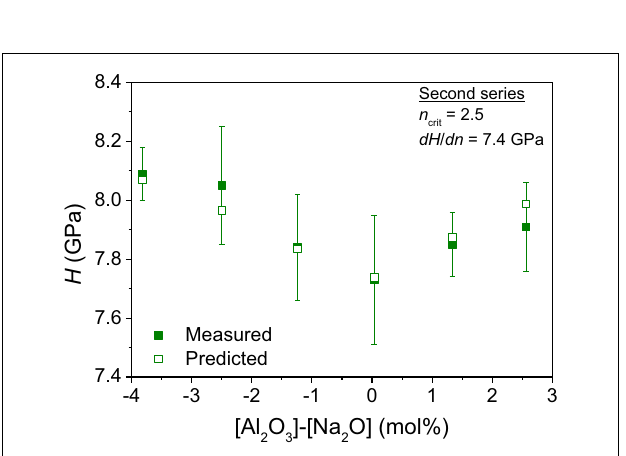
FIGURE 2 | Composition dependence ofVickers hardness ( H ) for the second series of boroaluminosilicate glasses: (84.4 − x )SiO 2 − x Al 2 O 3 − 11.6 B 2 O 3 − 4.0 Na 2 O with x = 0, 1.4, 2.7, 4, 5.3, and 6.6 .The filled squares represent the experimental data points, whereas the open squares represent the computed H ( x ) values with Eq. 1 ( dH / dn = 7.4GPa) using the analyzed compositions and 11 B and 27 Al MAS NMR data (Smedskjaer et al.,